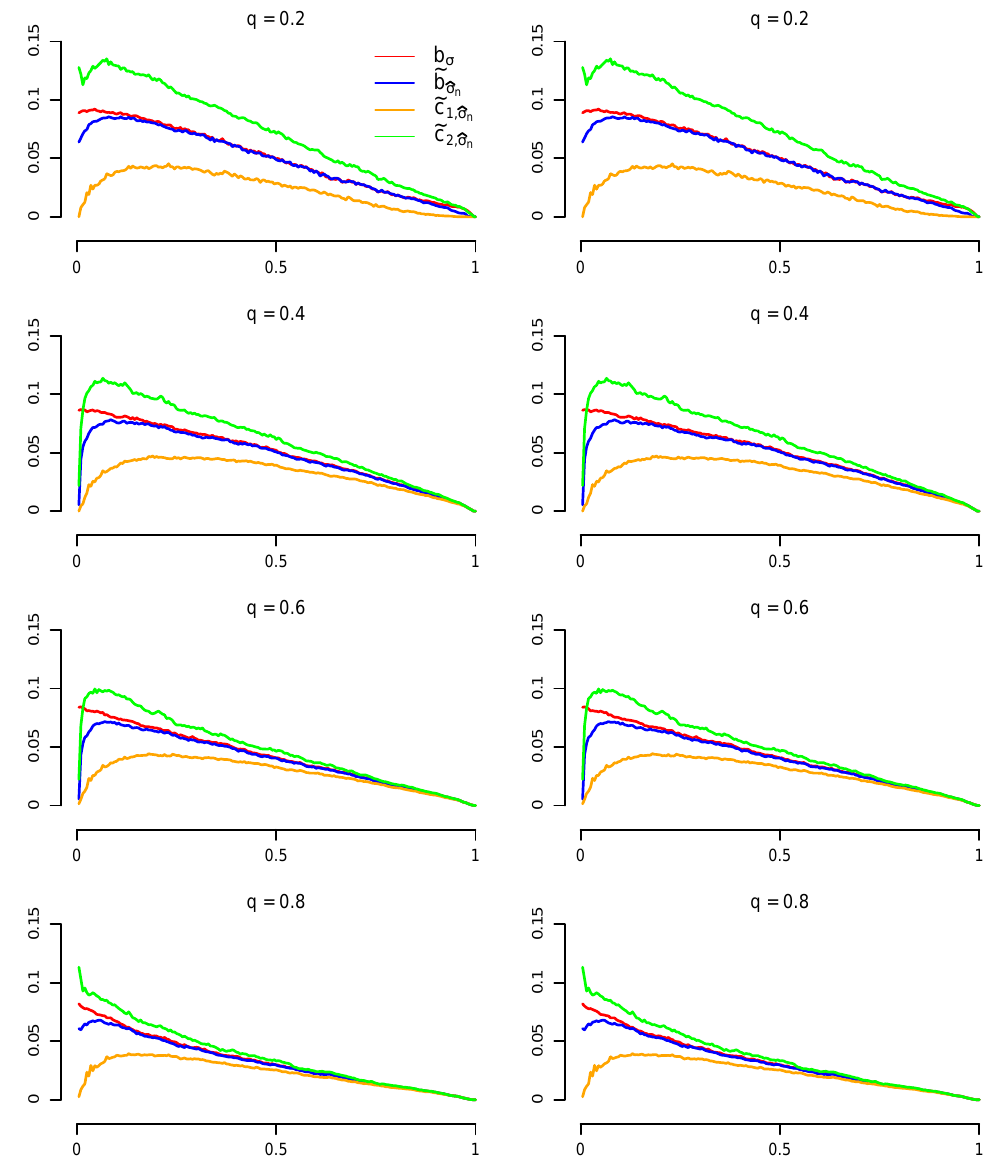
Figure 6. Variances of the payoff associated with: the true boundary b σ (red curve), the estimated boundary ˜ b (blue curve), the upper confidence curve ˜ c 1, (cid:98) σ n ˜ c 2, (green curve). The left column shows the low-frequency scenario ( r = 1), while the right one (cid:98) σ n stands for the high-frequency scenario ( r = 25). We use σ = 1, T = 1, S = 10, X 0 = 10, and λ =